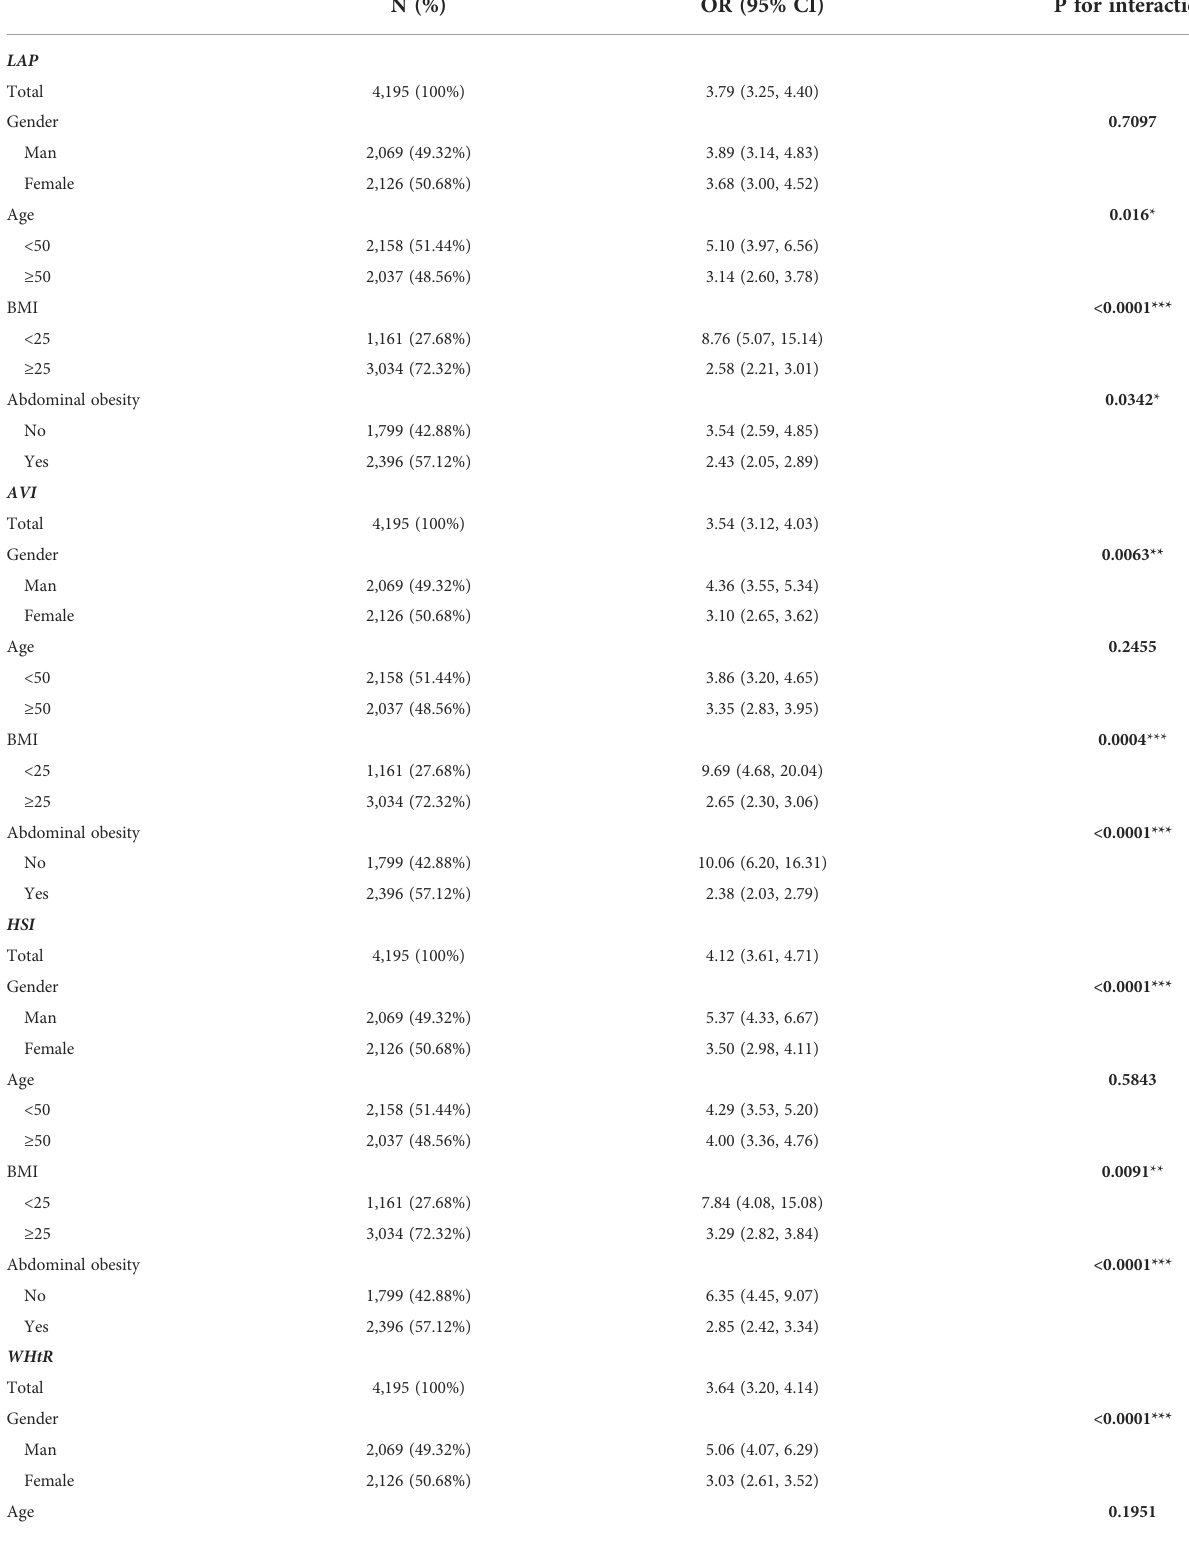
TABLE 4 Multivariate logistic regression models evaluating the associations of anthropometric indices with MAFLD strati fi ed by gender, age, BMI, and abdominal